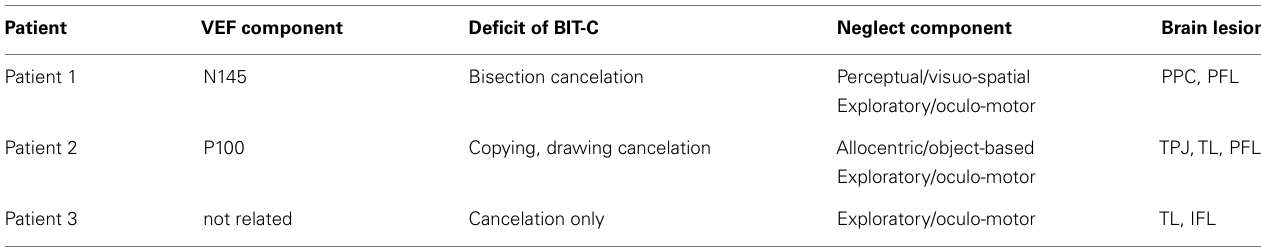
Table 3 |The absent visual evoked magnetic field component, behavioral inattention test deficits, neglect components, and brain lesion location in all